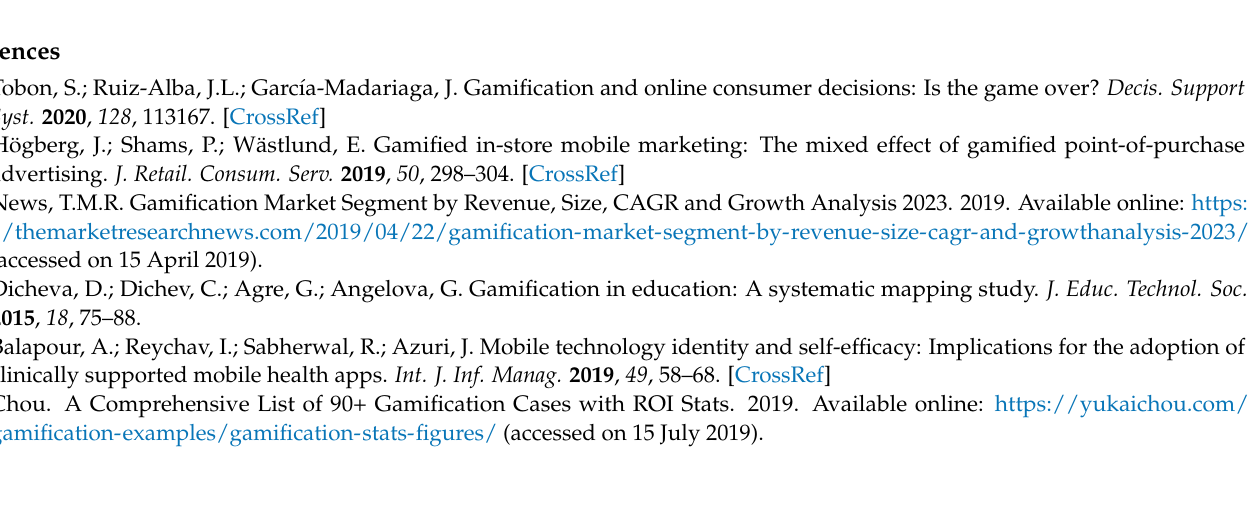
Table S4: CMV-CLC results; Table S5: Reliability and Convergent Validity; Table S6: Heterotrait- monotrait ratio of correlations matrix (HTMT matrix); Table S7: Fornell-Larcker